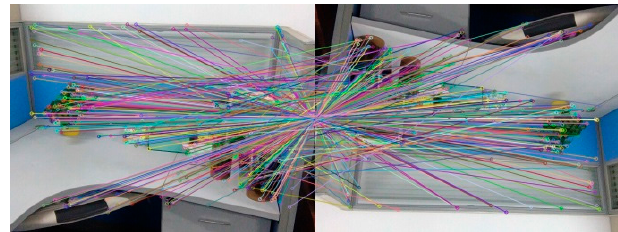
Figure 11. Image A registered with its own after local blur processing. Table 5. The correct matching number of 3 algorithms after image blurring.